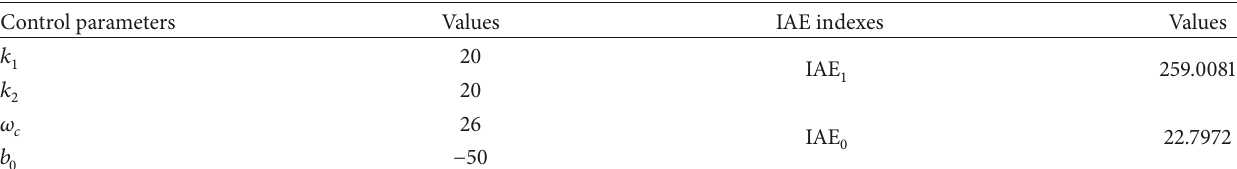
Table 4: Control parameters and IAE values (in presence of parameter